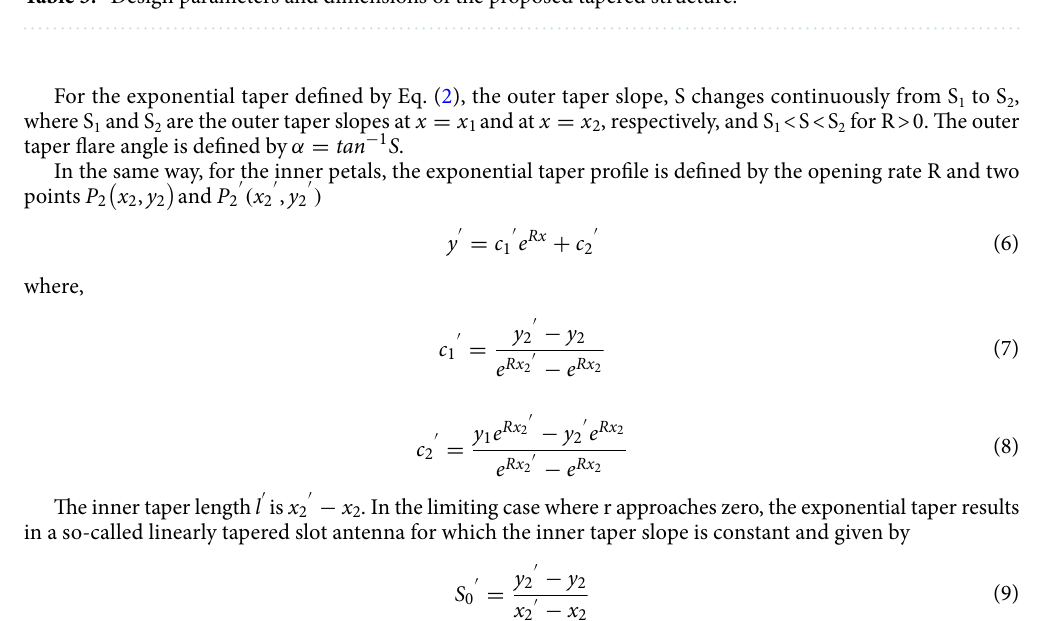
Table 3. Design parameters and dimensions of the proposed tapered